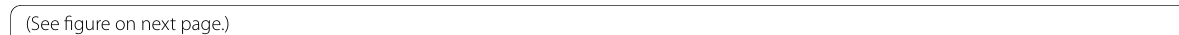
significant(See figure on next Fig. 3 Horizontal position of the first fixation. A , B Scatterplots (with best-fitting regression lines) showing the relationship between horizontal position (in degrees of visual angle) of the first fixation with face recognition ability, experience, and implicit racial bias for other-race faces ( A ) and for own-race faces ( B ). C Mean horizontal positions of the first fixation for other- and own-race faces as a function of 1 SD above and below the means of the measures of implicit racial bias (IAT) and face recognition ability (CFMT). 0°: the center of the face. L: towards the left side of the face; R: towards the right side of the face. For other-race faces, the horizontal position of the first fixation was positively predicted by experience with the other race, and negatively predicted by implicit racial bias. For own-race faces, the regression model was not